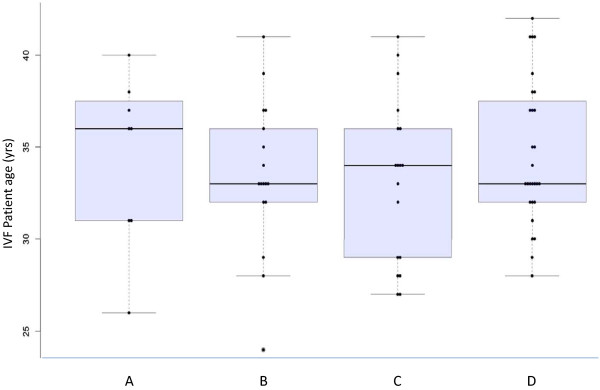
Patient preference to reduce number of daily injections vs. IVF patient age. Preference distribution regarding decreasing the number of daily injections and importance of reducing out-of-pocket (non-reimbursed) cost as a function of IVF patient age, where patients recorded their priority for A (prefer to reduce total number of daily injections), B (prefer to reduce out-of-pocket cost), C (no preference if there were no difference in cost), or D (prefer GnRH-antagonist, but this would be influenced by cost).